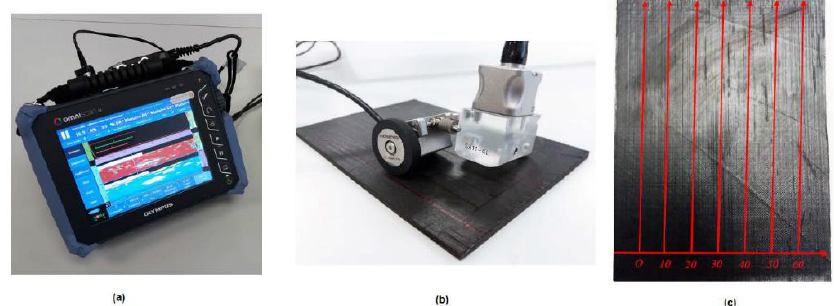
Figure 4 . Experimental setup of phased array ultrasonic testing. ( a ) Olympus Omniscan SX. ( b ) Phased-array transducer of 64 elements at 5 MHz with coupled encoder. ( c ) Details of the raster scan scheme for the composite laminates.